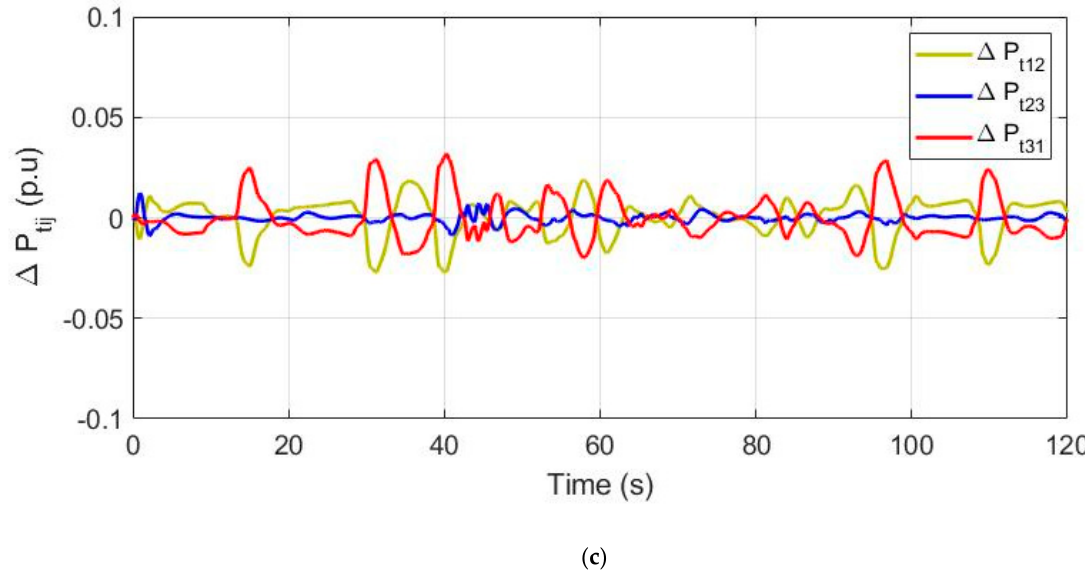
Figure 11. Case 3: ( a ) frequencies ( Δ f i ), ( b ) voltages ( Δ u i ), and ( c ) Δ P tij responses.